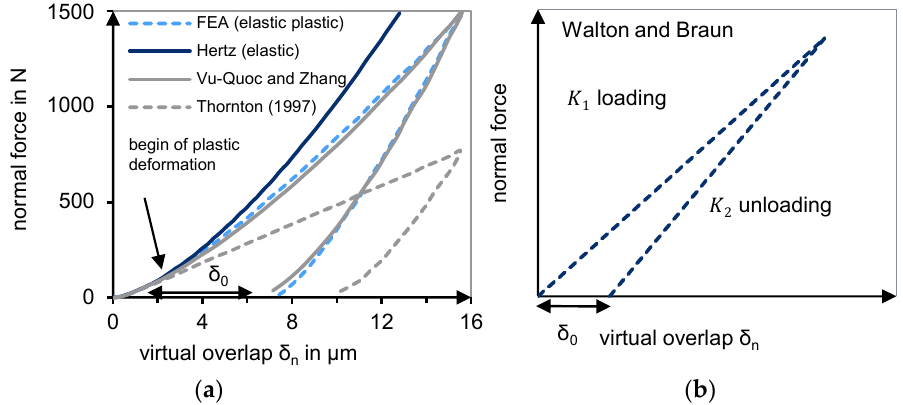
Figure 7. ( a ) Remaining plastic deformation after load adapted with permission from [46]. 2021 Vu-Quoc; ( b ) Contact model of Walton and Braun adapted with permission from [24]. 2021 Trippe.